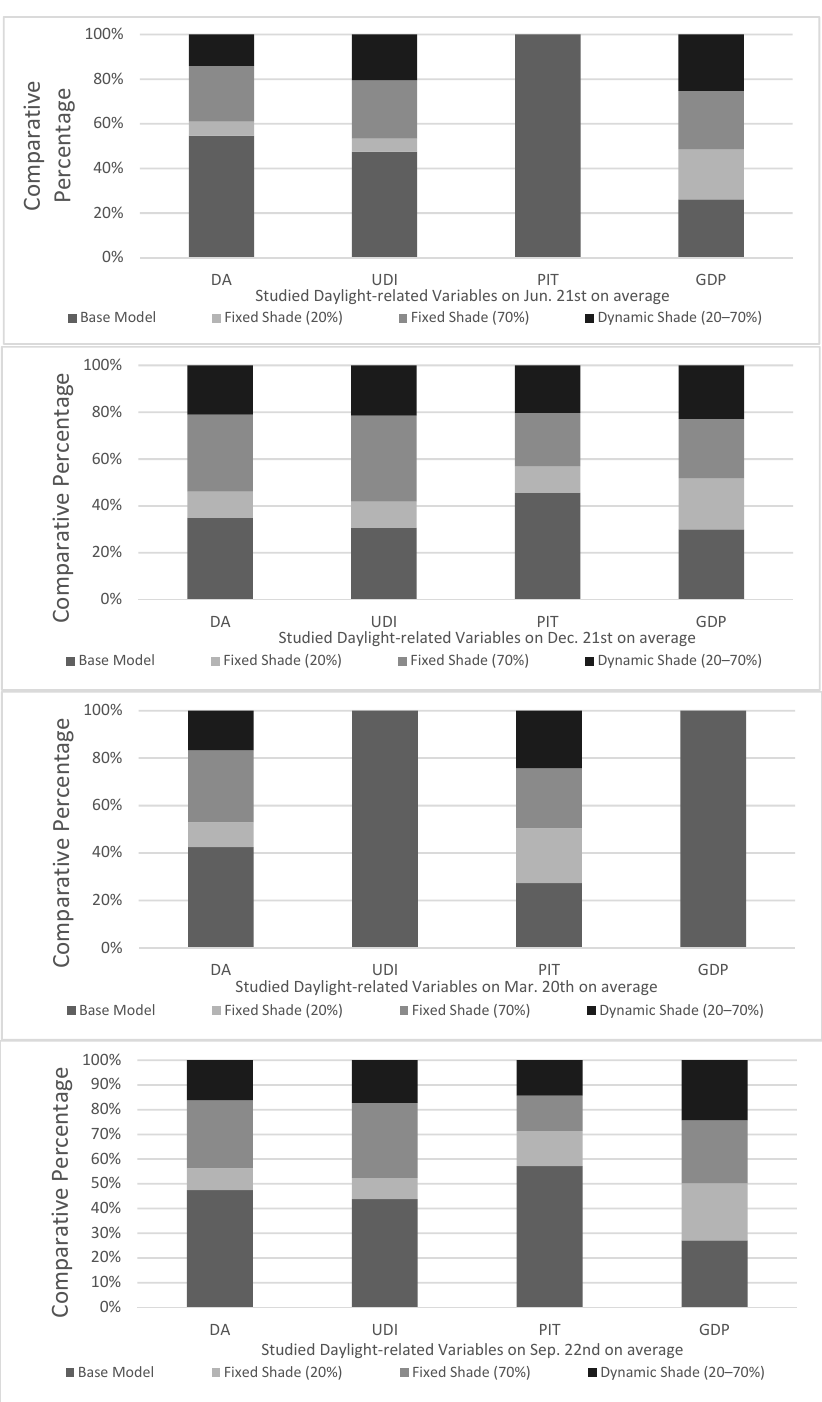
Figure 18. Comparative analysis of daylight ‐ related variables.